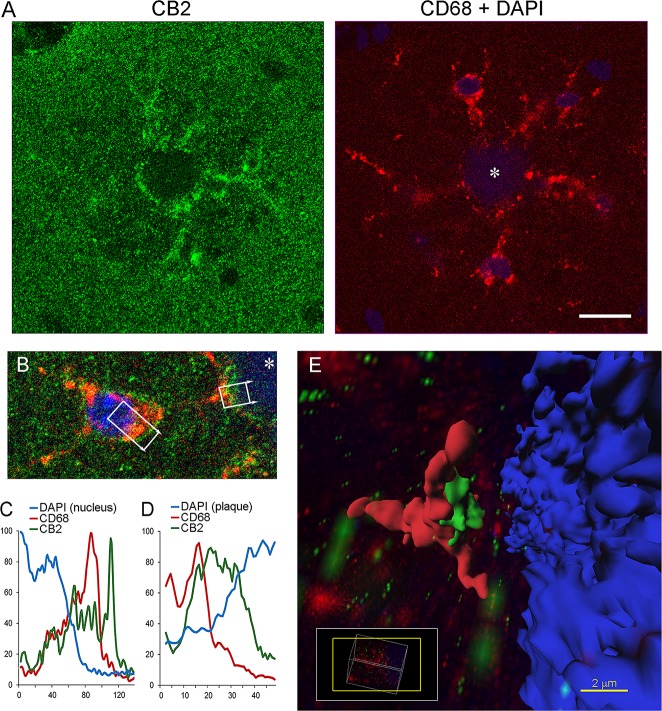
Localization of CB2 receptors in microglial cells and engulfment synapses.(A) A confocal image of CB2 (green) and CD68 staining (red) centered at the core of an Aβ plaque (marked by an asterisk). Note a region of high intensity for CB2 and CD68 staining around the plaque implying that CB2 receptors are localized in microglial processes surrounding the plaque. Scale 15 μm. (B) A magnification of a microglia cell body (red) and its process (red) forming an engulfment synapse on a dense core amyloid plaque (marked by an asterisk, DAPI). Note CB2 receptor staining along the edge of CD68-positive staining and at the engulfment synapse. White boxes indicate areas used for quantifications in C-D. (C-D) Quantification of CB2, CD68, and DAPI signals from the image of a microglia cell body (C) and engulfment synapse (D). The quantification was done using a Plot profile analysis tool (Fiji). Signals were averaged along short axes of boxes shown in B and normalized to a max value (100%) for each channel. Units of X axis are pixels, scale: 11.1 pixels/ μm. (E) 3D reconstruction of the engulfment synapse shown in B, D. A z stack of 0.31 μm slices (n = 29) was processed by using a background subtraction function and normalization for each of the channels. Surfaces for the plaque (DAPI), microglia process (CD68), and CB2 signal were created by arbitrary thresholding at an upper third of intensity distributions. Note high intensities of CB2 signals are located between CD68 and DAPI surfaces. Insert shows orientation of a 3D window as related to a position of the brain slide.